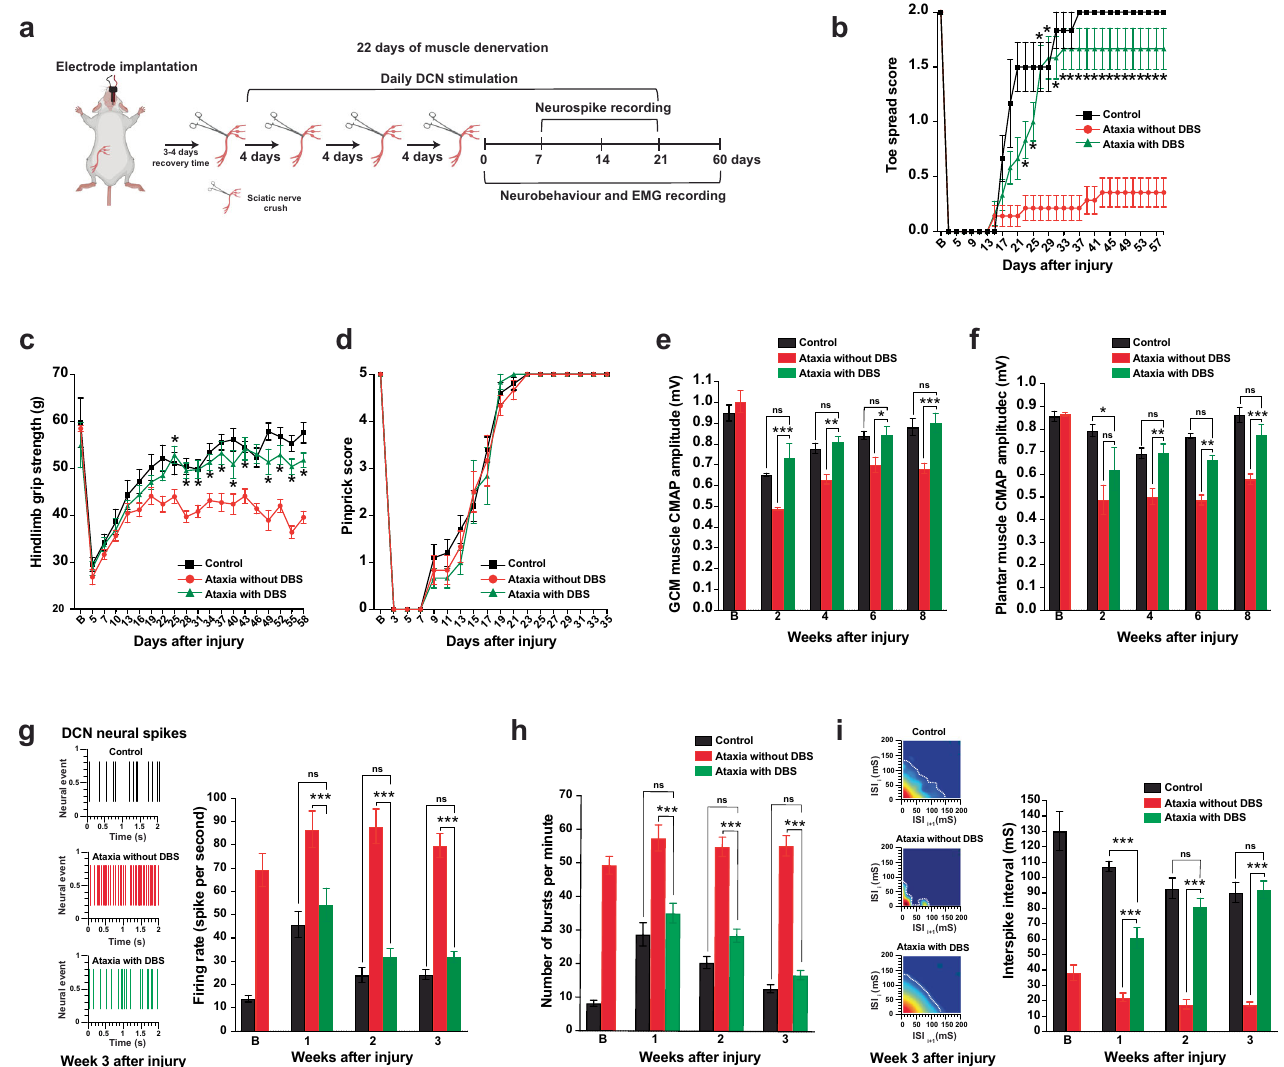
Fig. 4 Deep cerebellar nuclei deep brain stimulation (DCN-DBS) restores cerebellar circuitry and recovers motor function recovery after multiple sciatic nerve crush (SNC) injury. a Schematic diagram illustrating the experimental paradigm for the animal model of 22 days of muscle denervation and DCN-DBS treatment. Daily 1-h DCN-DBS was started after the fi rst SNC for 33 consecutive days. b and c Daily DCN- DBS reversed the motor de fi cits in ataxia mice, while ataxia mice without DBS were not able to fully restore motor function after SNC. d Recovery of sensory function was not affected in ataxia mice with or without DCN-DBS, when compared with control mice. e and f Ataxia mice with DCN-DBS recovered compound muscle action potential (CMAP) amplitudes from proximal and distal muscles gradually which were comparable to the control levels. g and h DCN neural fi ring rate and number of bursts in ataxia mice with DCN-DBS were indistinguishable from controls throughout the assessment period. Representative DCN neural fi ring patterns were shown in the left panel of g . i Average interspike intervals (ISI) of ataxia mice were increased gradually and comparable to control from week 2 post-SNC onwards. Representative ISI distribution heat maps were shown in the left panel. n = 8 – 10 mice per group for neurobehavioral experiments in b – d ; n = 6 – 8 mice per group for EMG recording ( e and f ) and DCN neurospike fi ring analysis ( g – i ). Values represent the mean ± SEM; two-way ANOVA followed by post hoc Bonferroni test; * P < 0.05; ** P < 0.01; *** P < 0.001. ns; non-signi fi cant. Detailed statistics analyses comparing CMAP amplitude data points across time within groups are available in Supplementary Table days following a single SNC (Supplementary Fig. 8a). We found interval (Supplementary Fig. 7d, e) in DCN neurons of ataxia mice persistent aberrant neural fi ring in ataxia mice during the course compared to control mice. Interestingly, there was a trend of of recovery. By contrast, DCN-DBS restored the cerebello-cortical increase in neural fi ring and number of bursts in control mice at network by reducing the aberrant neural fi ring (Supplementary 2-week post-SNC onward, and the increment was more prominent Fig. 8b) and the number of bursts (Supplementary Fig. 8c) and in ataxia mice. It is possible that deafferentation due to SNC results increasing the interspike interval (Supplementary Fig. 8d) as early in neuroplasticity modi fi cation in the cerebellum since cortical as one week after DCN-DBS. Ataxia mice with DCN-DBS and reorganization occurs following sciatic nerve injury 13 . control mice reached full toe spreading re fl ex, and restored grip We then performed DBS targeting interposed nucleus of DCN to strength and EMG activities in a comparable manner without any restore neural fi ring pattern in ataxia mice followed by SNC and delays. However, implanted ataxia mice without DCN stimulation behavioral tests. Mice received 1 h of daily DCN-DBS at 130 Hz/ exhibited signi fi cant delayed full toe spreading re fl ex, and 100 µA/80 µs 51,52 using multielectrode arrays for 21 consecutive